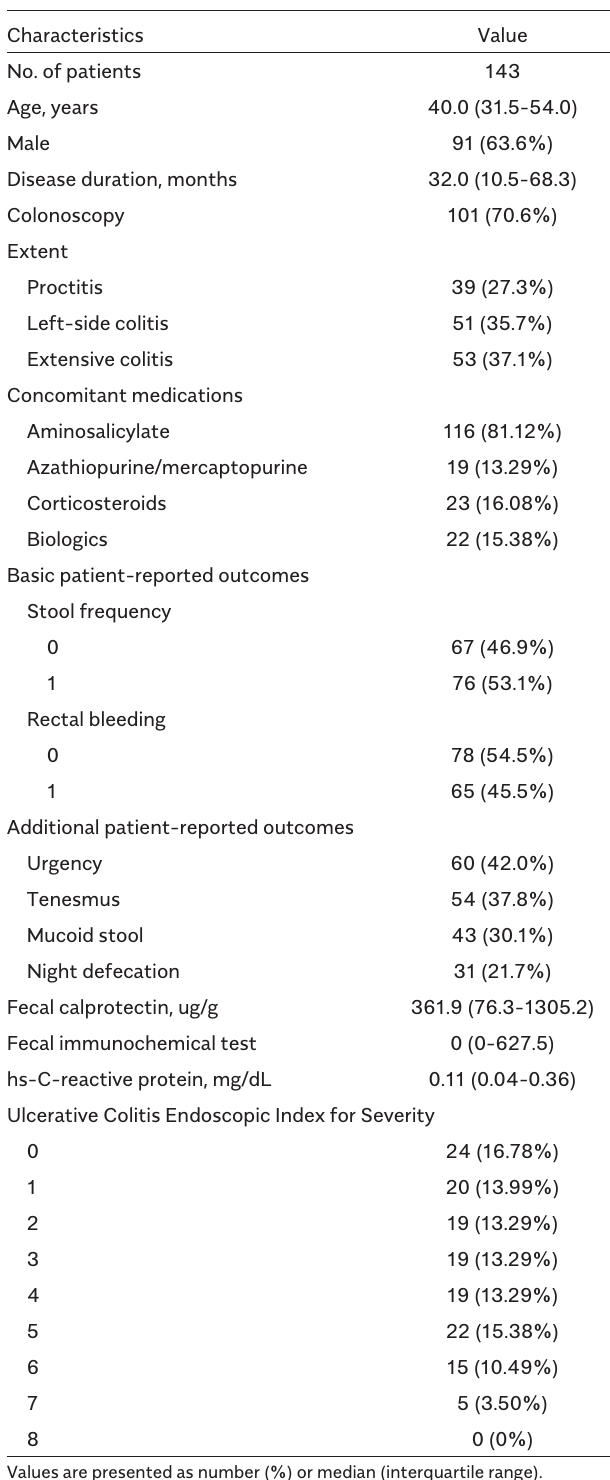
Table 1. Baseline Characteristics of the Study Population